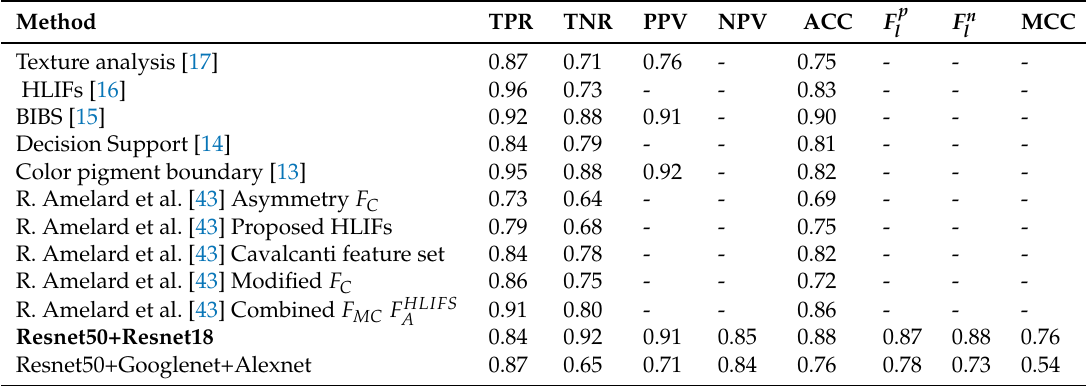
Table 5. Experimental results on the Skin-lesion